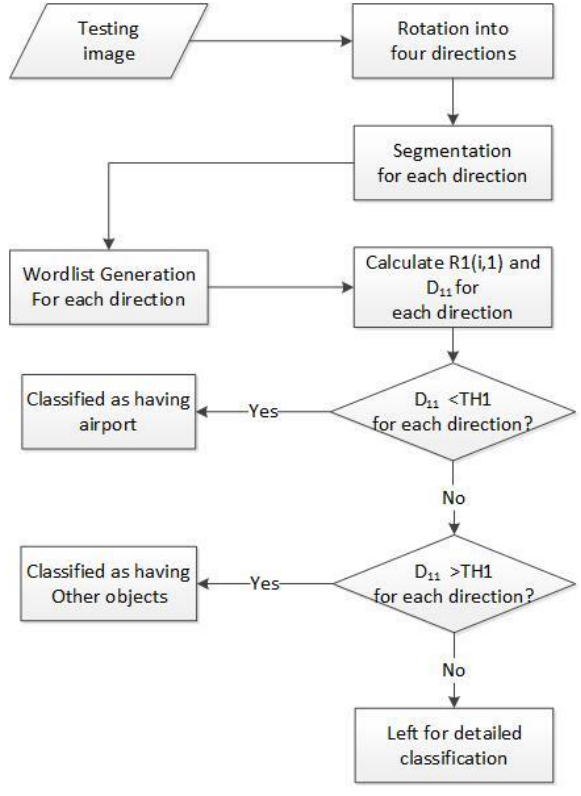
Figure 6. Procedure of preliminary classification.